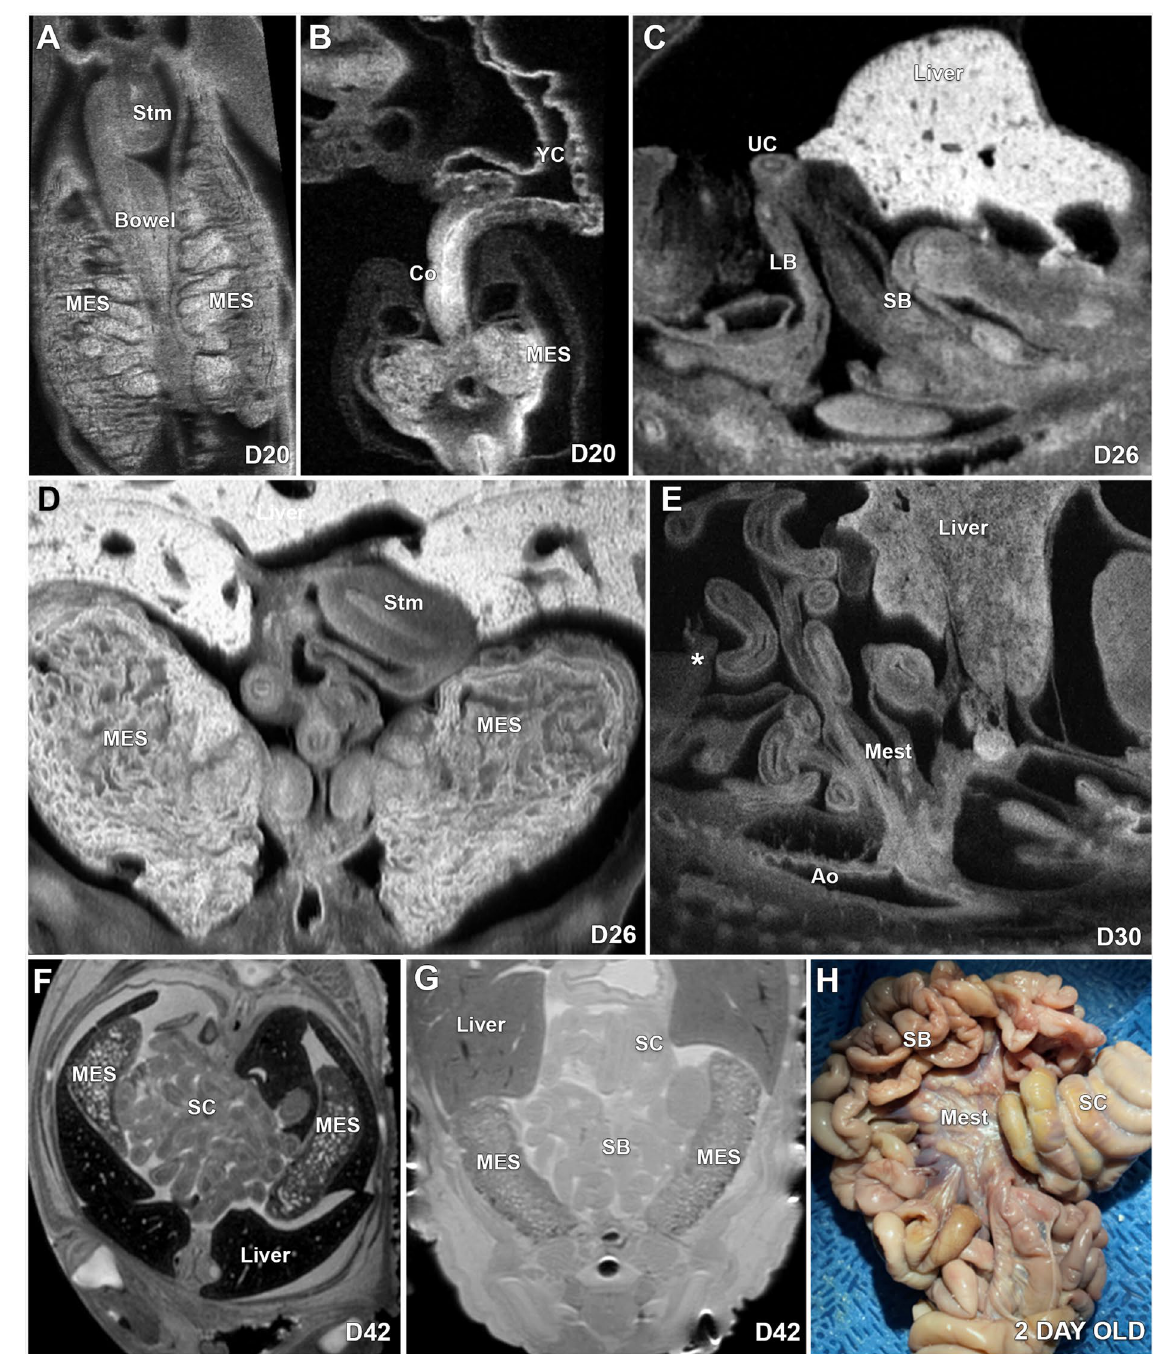
Figure 5. ECM, MRI and gross images of the development of the stomach and intestine in the pig at D20 to 2 days of age. ( A ) shows the early developing stomach and ( B ) shows the relationship of the colon to the yolk sac at D20, and at D26, bowel has herniated to the base of the umbilical cord with part of the bowel located outside the abdominal cavity ( C ) and the bowel is in the process of rotating ( D ). At D30 ( E ), a portion of the bowel is still herniated through the normal opening in the fetal abdominal wall and the * shows the posterior limit of the abdominal wall opening and the mesentery is well-formed. At D42, the bowel is completely located within the abdomen, the abdominal wall is intact, and the rotation of the bowel appears completed ( F ) and by MRI, the spiral colon is well-formed ( G ). Illustration ( H ) is an ex-situ specimen of the small bowel and spiral colon in a 2-day old pig. Stm-Stomach, MES-Mesonephros, YS-Yolk sac, Co-Colon, UC-umbilical cord, SB-Small bowel, LB-Large bowel, Mest-Mesentery, Ao-Aorta, SC-Spiral colon, *- Border of the fetal abdominal